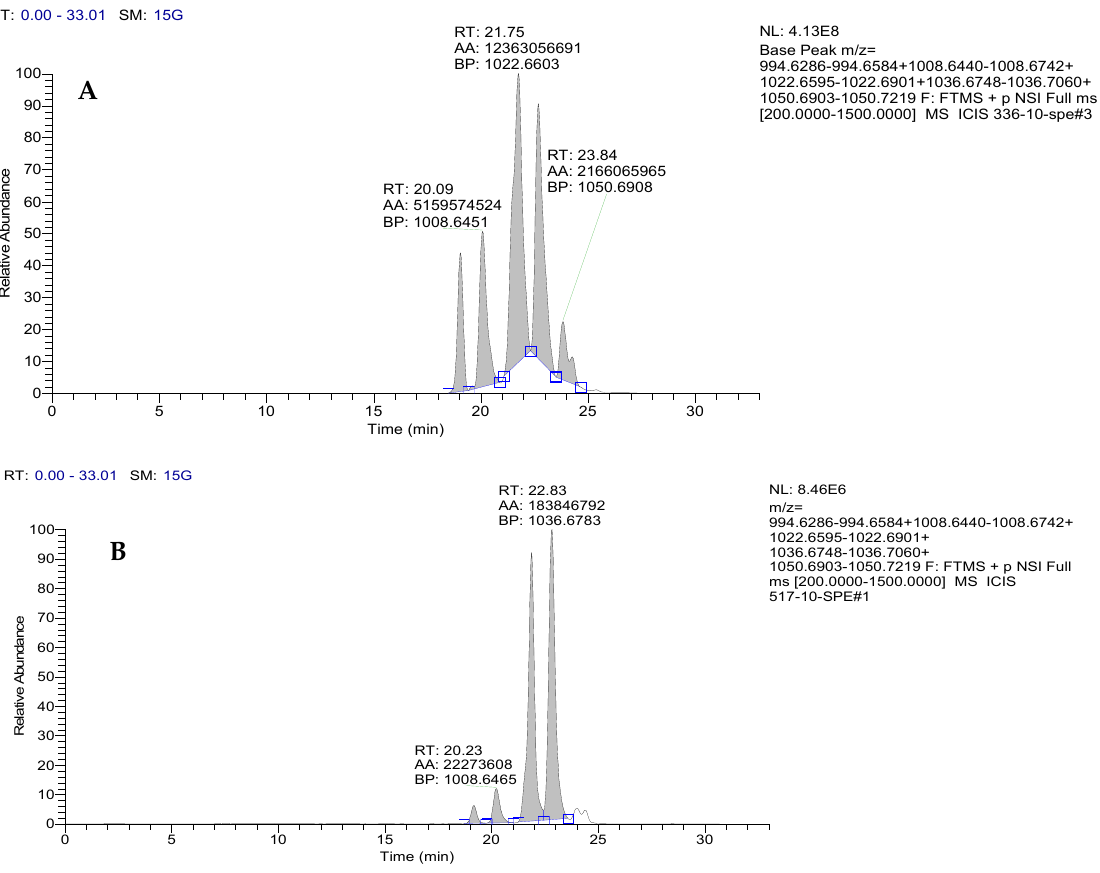
Figure 10. Base peak mass chromatogram in positive ion detection mode of Surfactin A-CH2, Surfactin A, Surfactin B, Surfactin C, and Surfactin C + CH 2 for samples BZR 336 g ( A ) and BZR 517 ( B ).